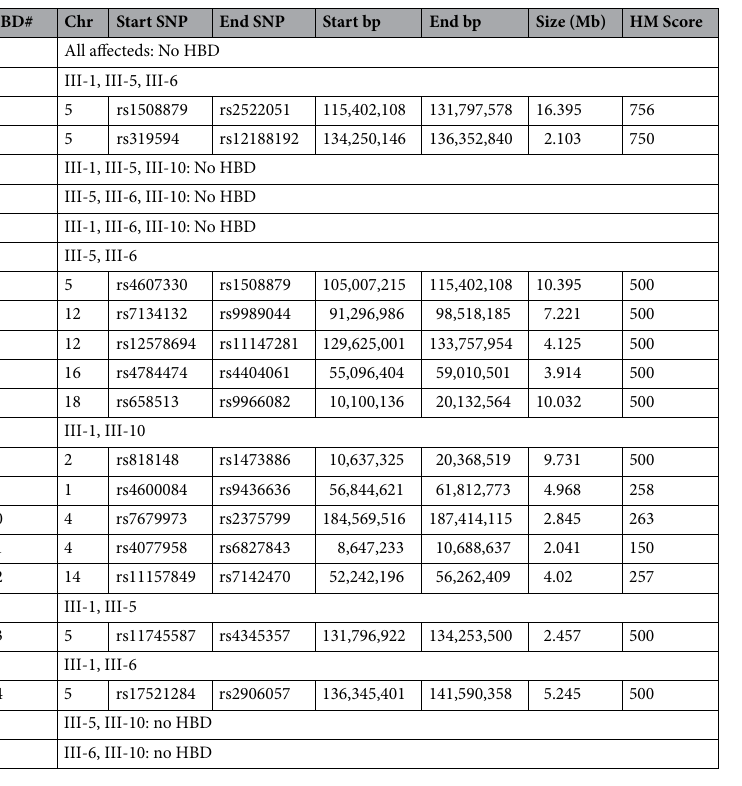
Table 1. Homozygosity-by-descent (HBD) mapping using Illumina Human CoreExome genotype data for family members III-1, III-5, III-6, III-10 (affected), and III-2, III-7 and III-8 (unaffected), using Homozygosity Mapper 23 . As no HBD regions were identified for all four affecteds, in order to explore possible genetic heterogeneity, a reiterative analysis was performed for subsets of three or two affecteds, with the other affecteds re-classified as controls purely for the purpose of analysis. Coordinates provided in